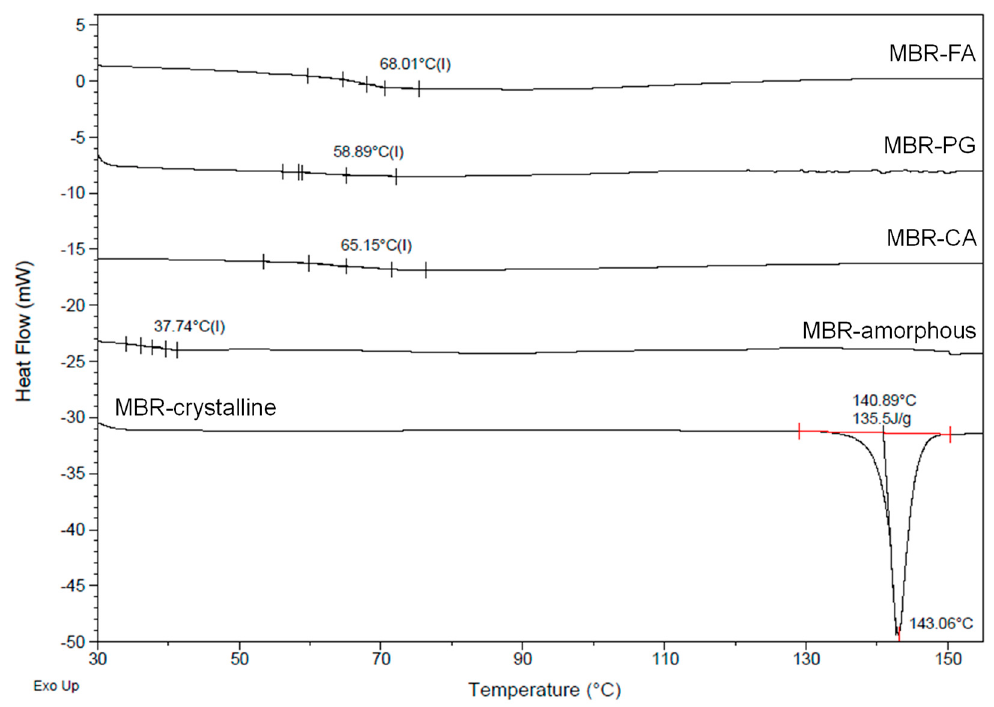
Figure 8. Differential scanning calorimetry (DSC) curves of MBR co-amorphouses (MBR-FA, MBR-PG, and MBR-CA), MBR crystalline, and MBR amorphous (heating rate 10 °C /min).